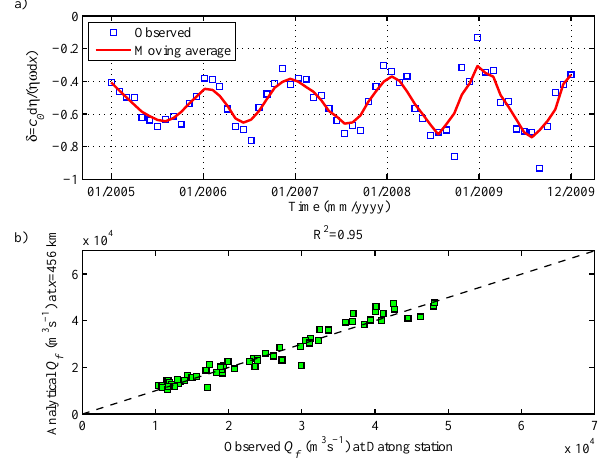
Figure 11. (a) Comparison between observed tidal damping δ and its corresponding moving average value with a window of 5 months; (b) comparison between analytically predicted fresh water dis- charge and observations (at Datong tidal station) in the Yangtze estuary in different months of 2005–2009. R 2 is the coefficient of